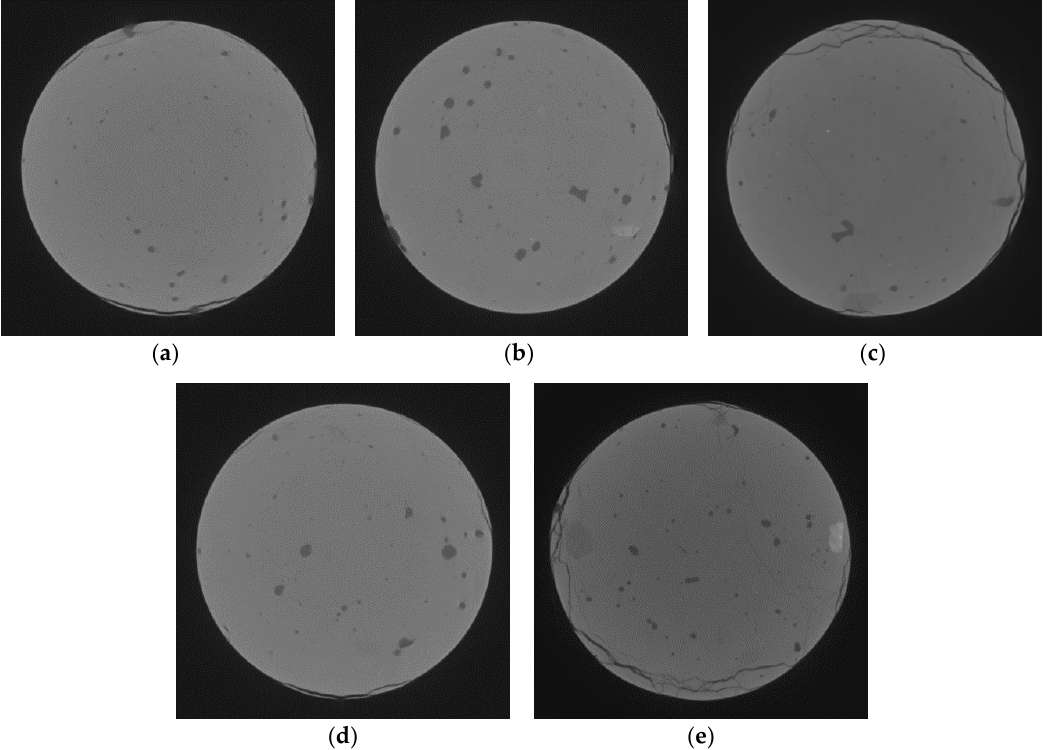
Figure 14. Examples of cracking in HPC specimens. H-Series the five different sets of cycles: ( a ) 0 cycles: ( b ) 2000 cycles; ( c ) 20,000 cycles; ( d ) 200,000 cycles; ( e ) 2,000,000 cycles.